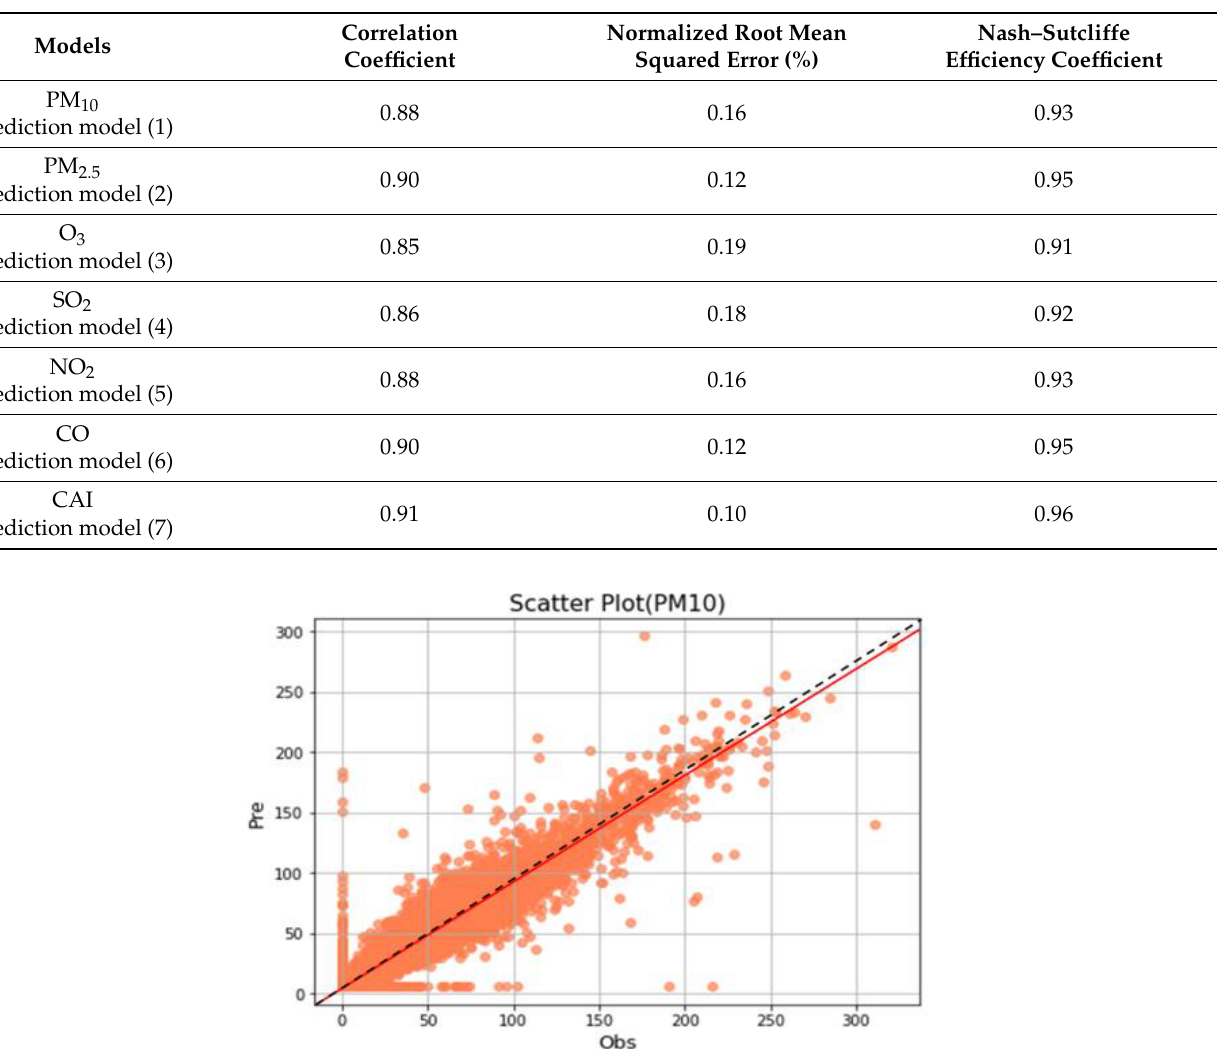
Table 4. Evaluation of predictive power by the LSTM and DNN models.